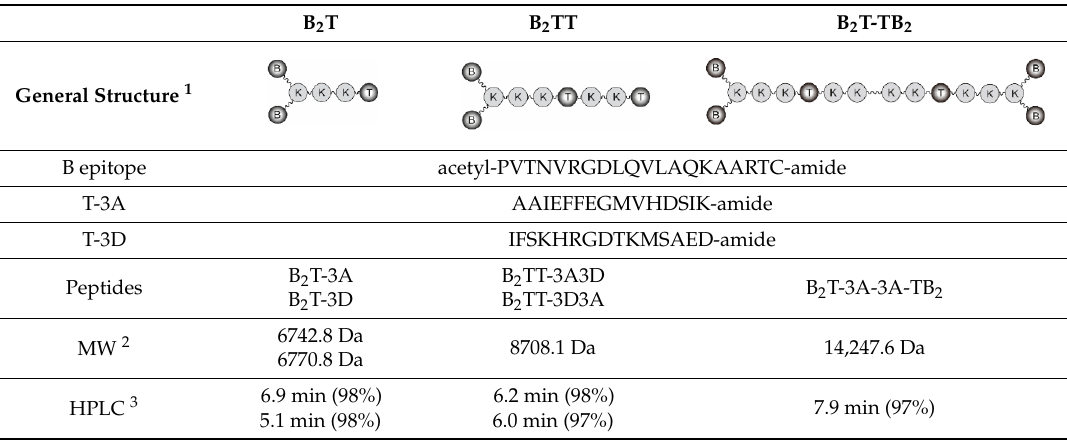
Table 1. B n T n dendrimeric constructions.